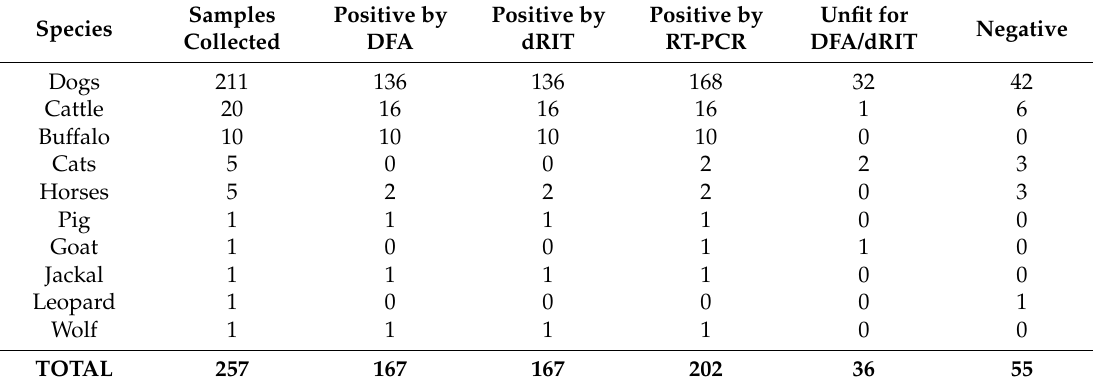
Table 2. Details of the results of DFA, dRIT and reverse transcription polymerase chain reaction